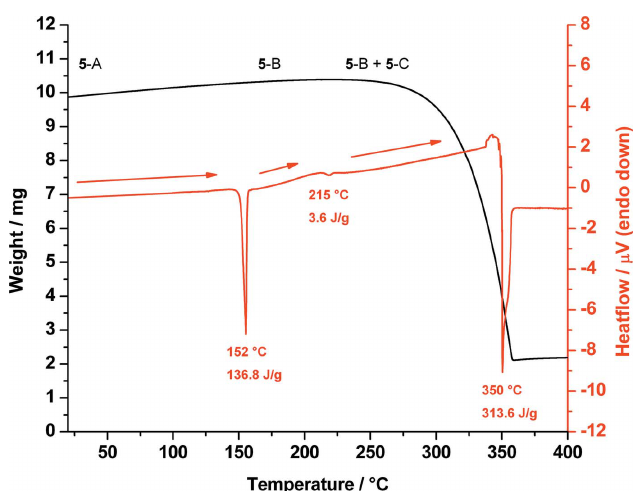
Figure 7 Combined DSC (red) and TGA (black) traces of cis -inositol ( 5 -A) measured from 20 to 400 (cid:2) C showing the phase transition of polymorph 5 -A to 5 -B at 152 (cid:2) C and 5 -B to 5 -C at 215 (cid:2) C until melting/ decomposition of 5 -C at 350 (cid:2) C.